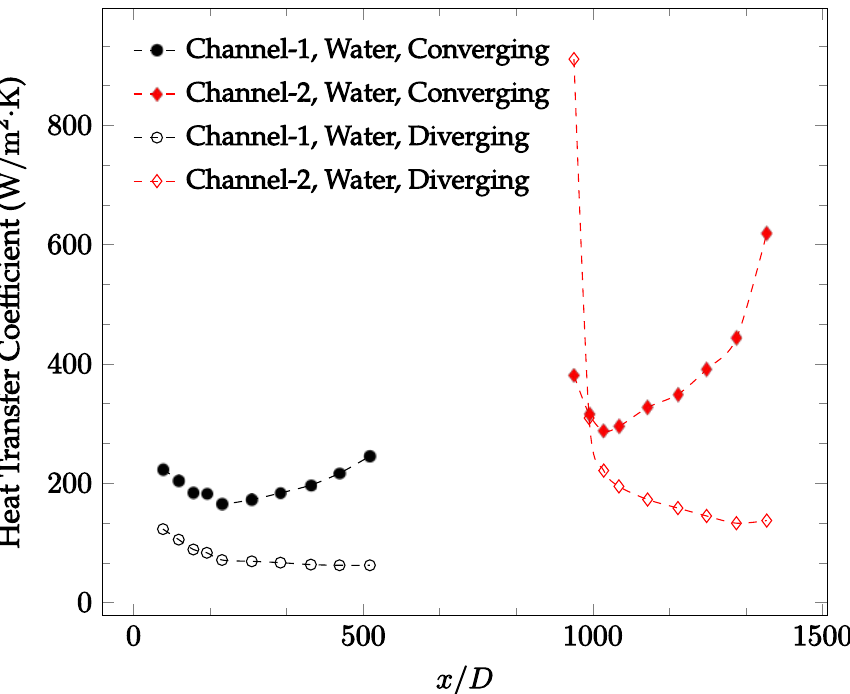
Figure 11. Change in convective heat transfer coefficient of deionized water as a function of dimensionless distance for a Reynolds number of 50. Converging and diverging nozzles are used as connectors.